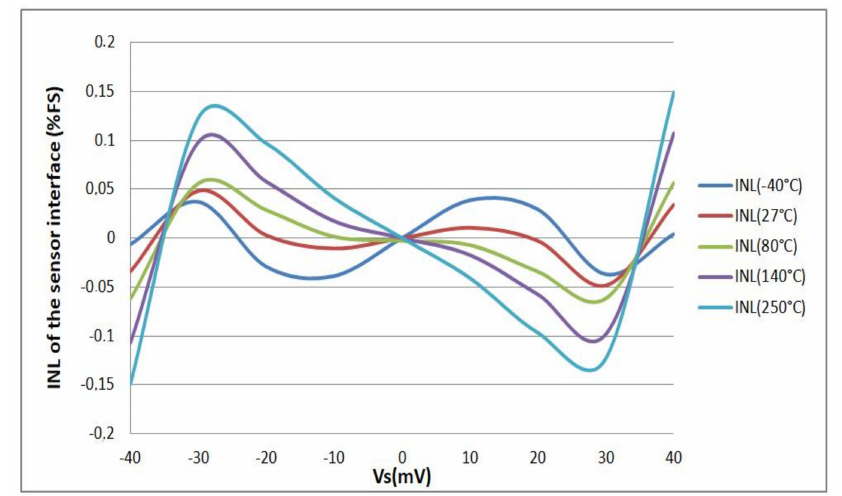
Figure 14. Simulated Integral Non-Linearity (INL) over a ± 40 mV input dynamic